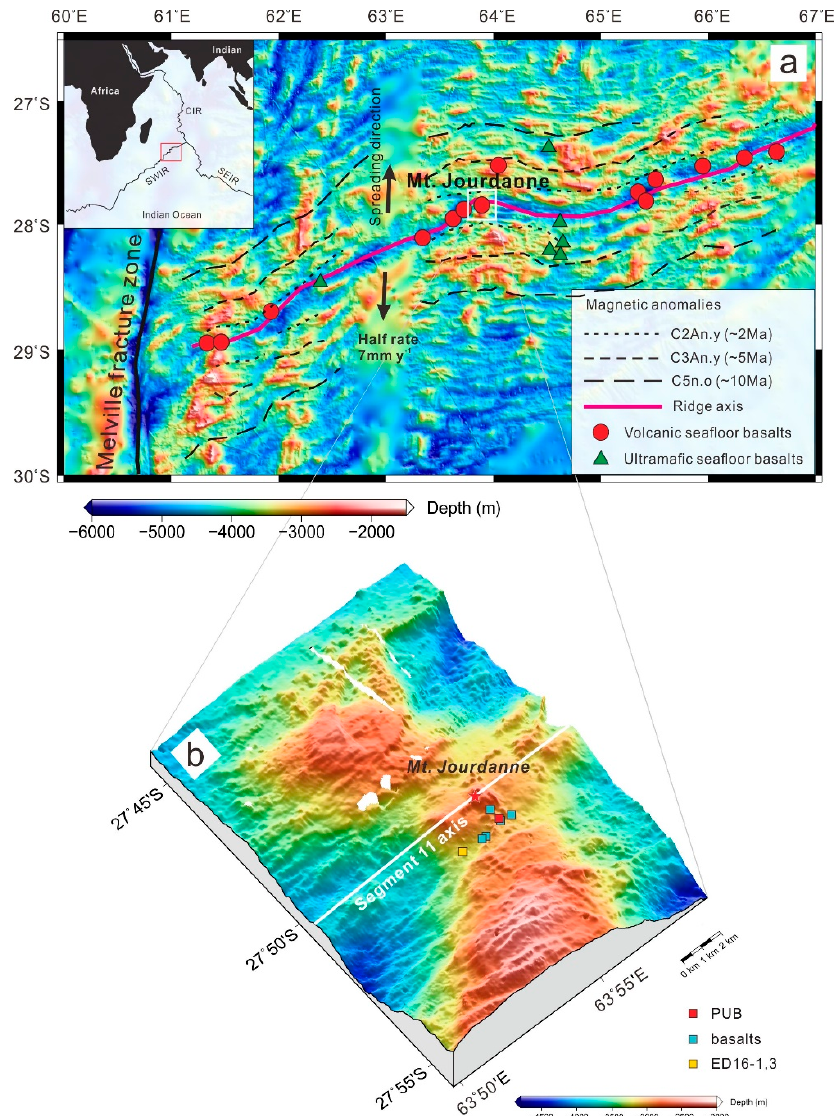
Figure 1. ( a ) Bathymetric map of the Southwest Indian Ridge east of Melville fracture zone (FZ), with the location of the Mount Jourdanne volcanic massif and regional basalts from volcanic, and ultramafic seafloor (according to Paquet et al. [30]). Inset shows the study area. ( b ) High-resolution bathymetry map with an oblique view of the Mount Jourdanne massif with the sample location of aphyric basalt and plagioclase ultraphyric basalts (PUBs) in this study. Samples ED16–1 and ED16–3 are from the literature data [30]. The base map was prepared using Generic Mapping Tools (GMT) [37]. CIR: Central Indian Ridge; SEIR: Southeast Indian Ridge.